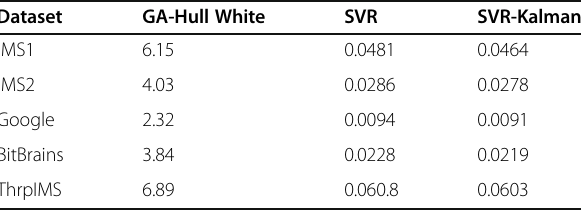
Table 6 Average execution time (seconds) based on 10 simulations, 60 generations for GA Dataset